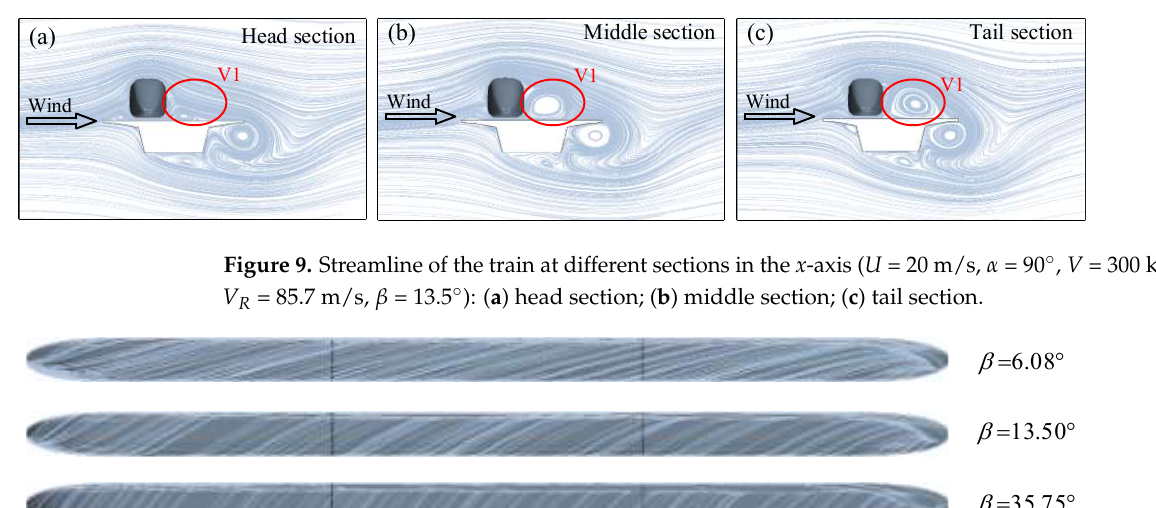
Figure 8. Pressure contour of the train at different sections in the x -axis ( U = 20 m/s, α = 90°, V = 300 km/h, V R = 85.7 m/s, β = 13.5°): ( a ) head section; ( b ) middle section; ( c ) tail section.